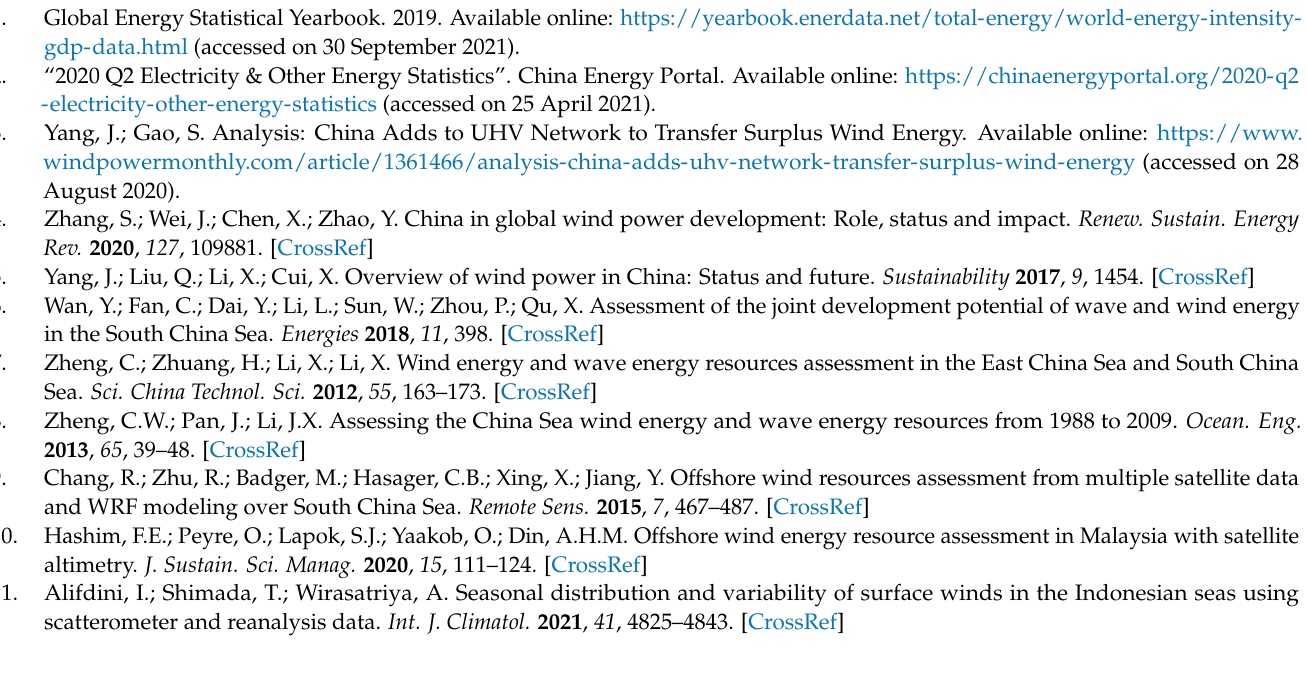
Figure A13. Taylor diagram for temperature in K from the models and observations at the locations ( 1 ) Shaoguan, ( 2 ) Nanping, ( 3 ) Ganzhou, ( 4 ) Offshore Quanzhou, ( 5 ) Offshore Shanwei, ( 6 ) Offshore Nansan, ( 7 ) Dongsha, ( 8 ) Zhanjiang and ( 9 ) Hong Kong.